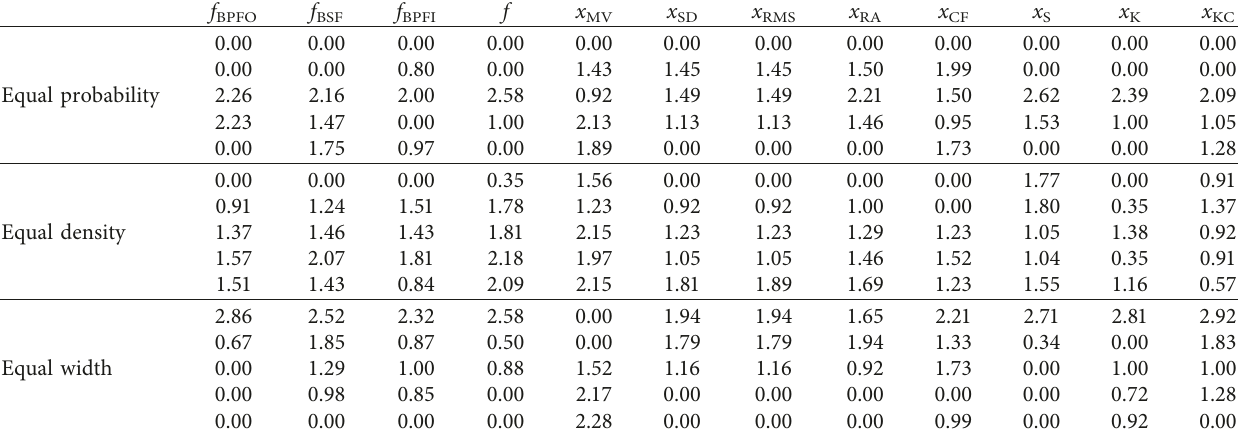
Table 2: Interval class-information entropy based on different discretization methods.